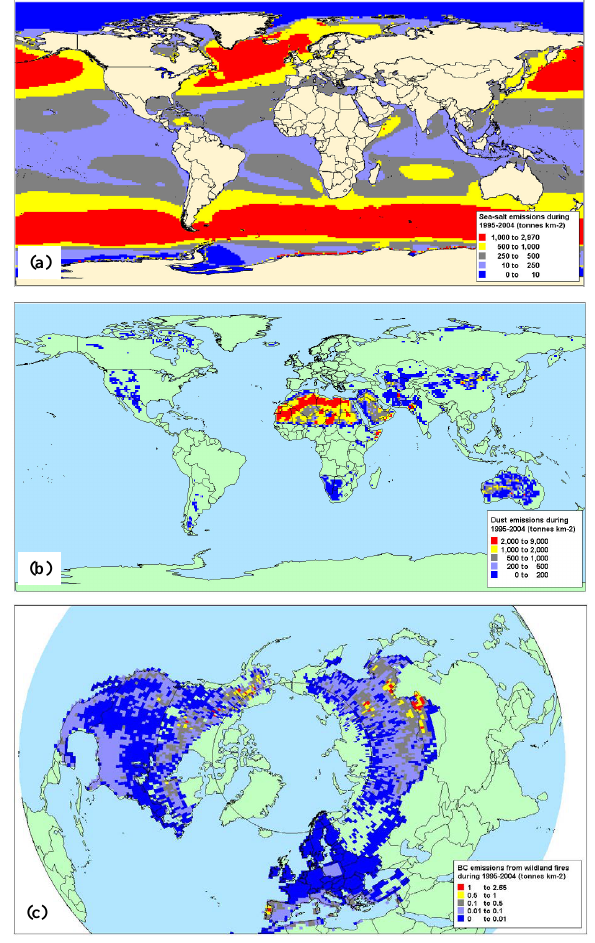
Fig. 3. Total emission maps of global sea-salt (a) , global mineral dust (b) , BC from boreal and temperate vegetation fires (c) in metric tonnes per km 2 during